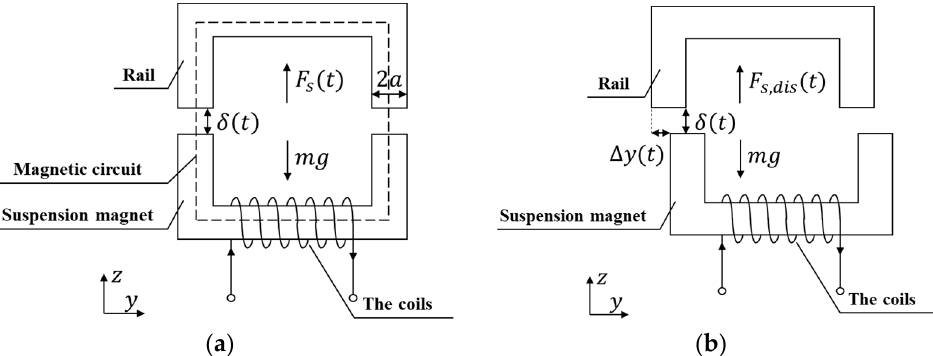
Figure 1. The single suspension magnet model. ( a ) The nominal state; ( b ) the state existing horizon- tal misalignment.